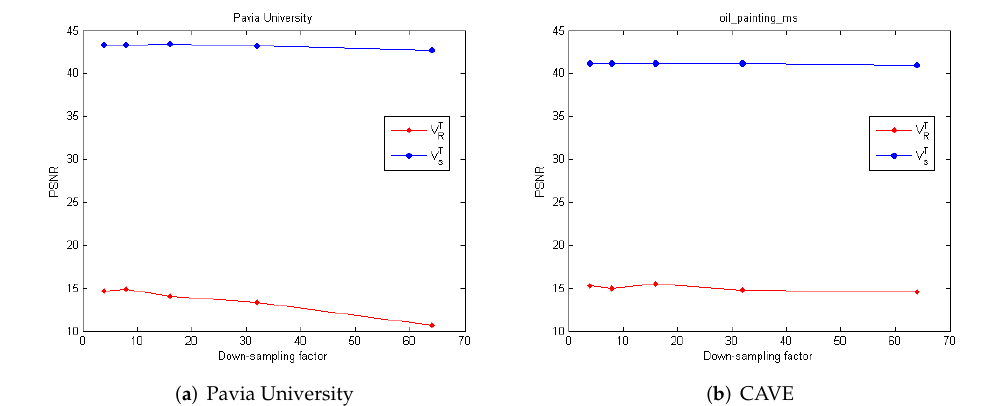
Figure 5. Impact of V T s to the fusion